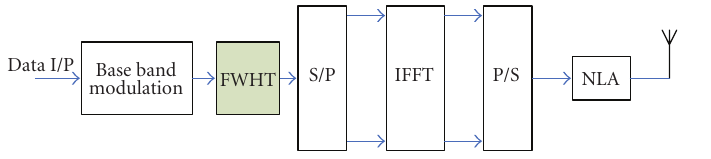
Figure 14: OFDM system block diagram.